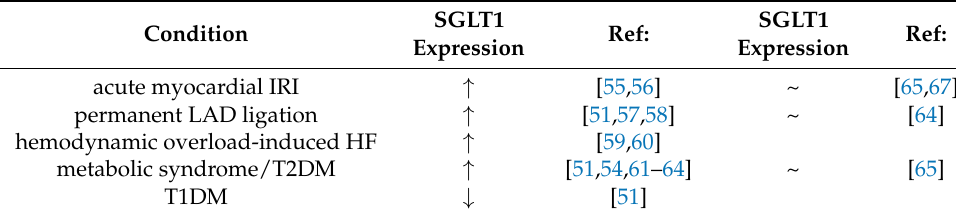
Table 4. Summary of studies in small animals investigating the expression of myocardial sodium– glucose cotransporter 1 (SGLT1) in various pathological conditions compared with healthy controls. SGLT1 Condition